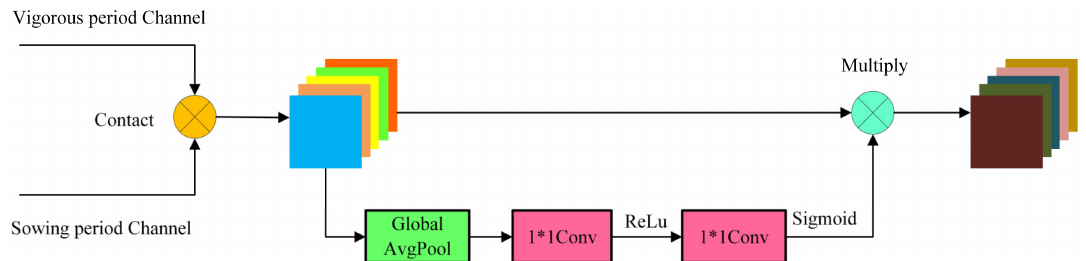
Figure 7. Time-series feature fusion